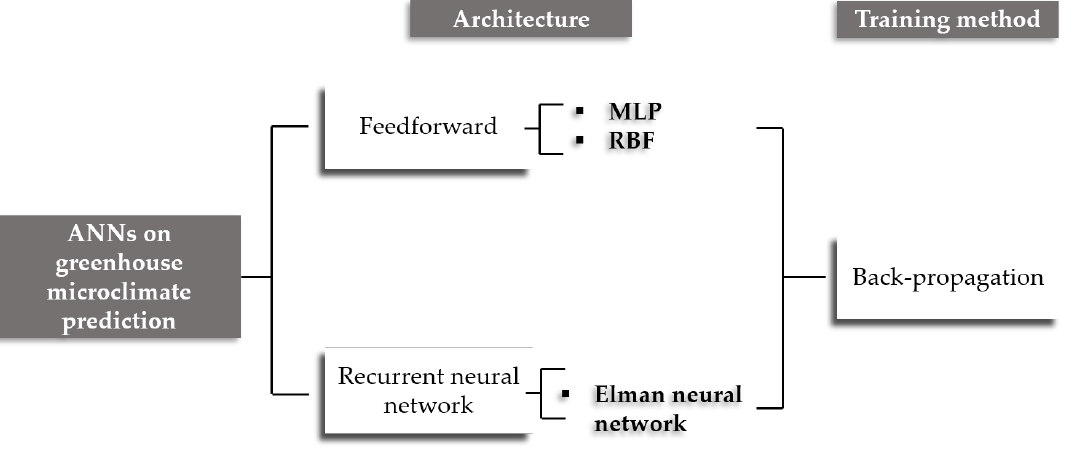
Figure 7. Artificial neural networks on greenhouse microclimate prediction. ANNs: Artificial neural networks; MLP: Multilayer perceptron; RBF: Radial basis function